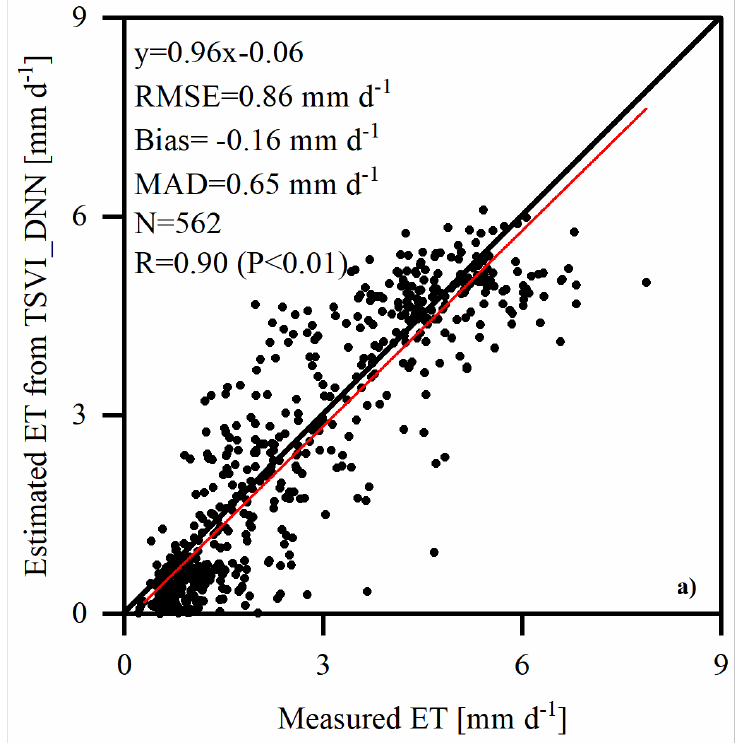
Figure 7. Scatterplot of ET estimates from the TSVI_DNN compared to the in situ measurements of ET.